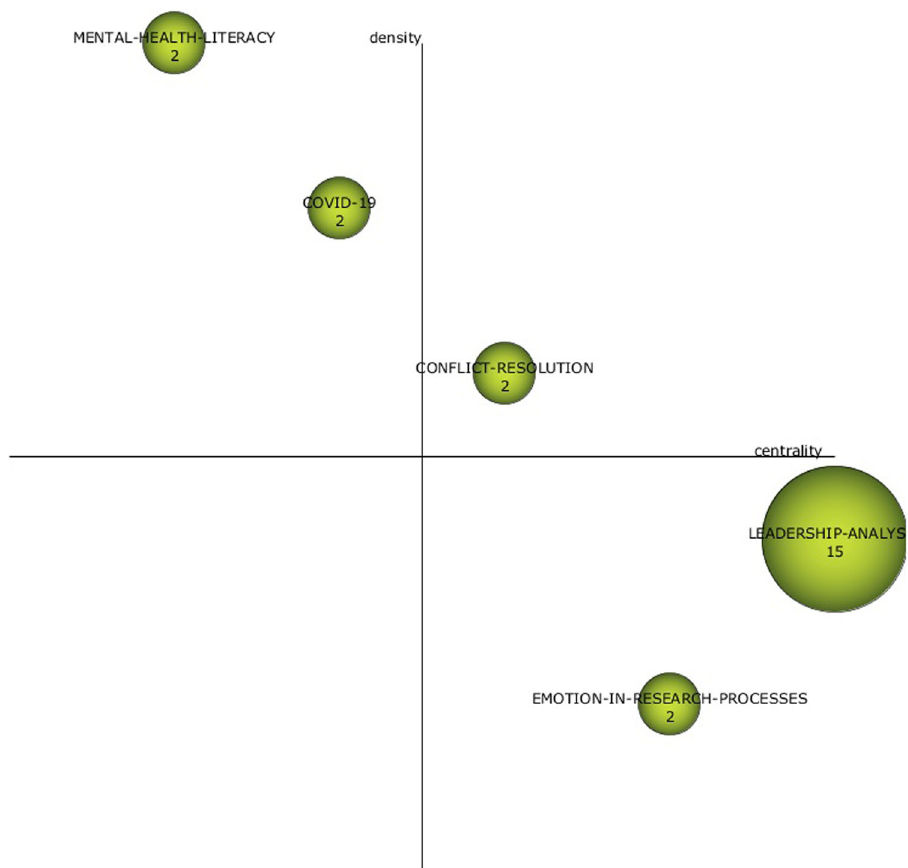
Fig. 8 Strategy diagrams by pandemic (2020 – 2022) period. Results from SciMat, diagram composed of themes by number of documents for (2020 –